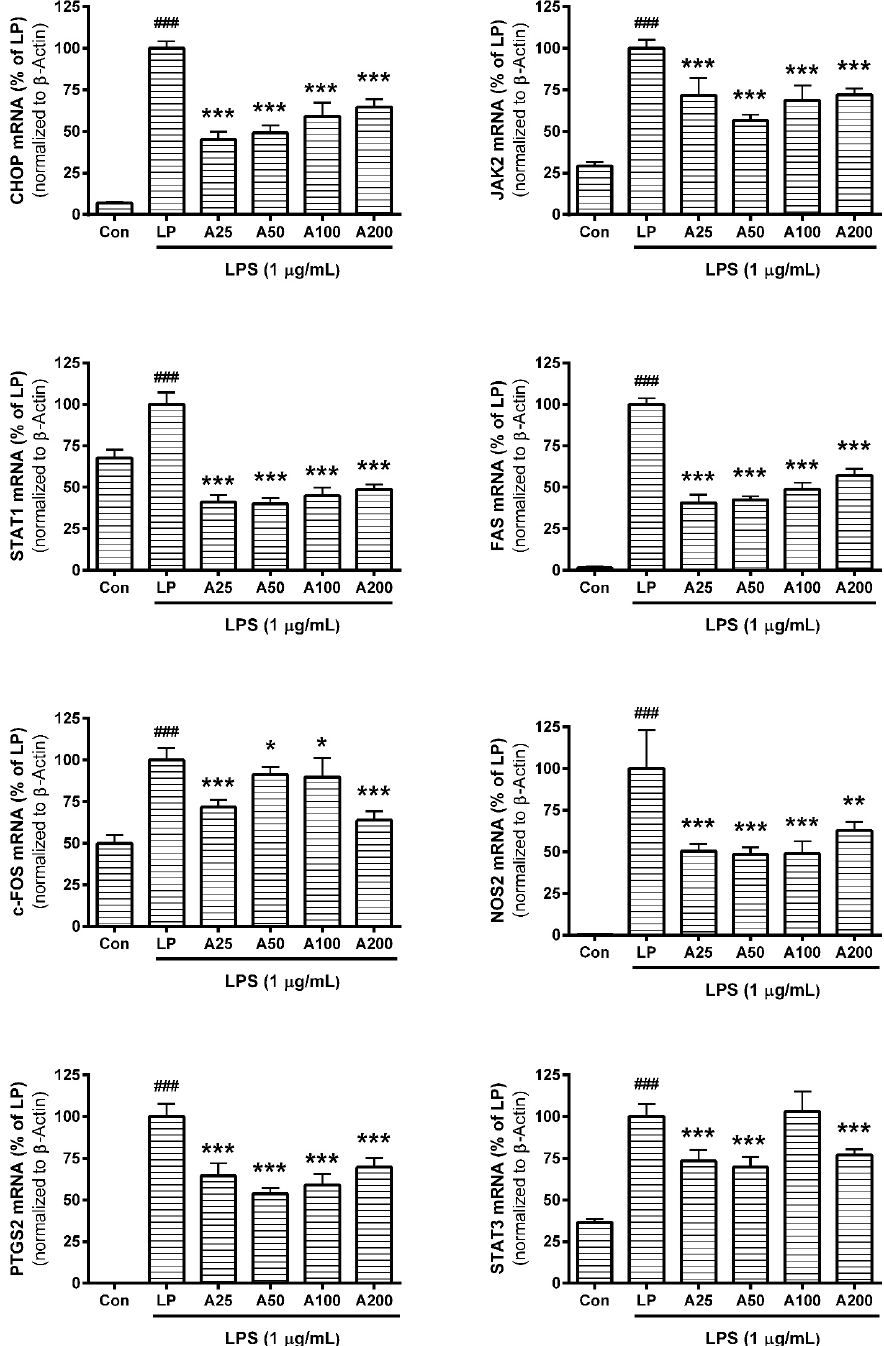
Figure 5. Effects of Angelica sinensis root water extract (ASW) on the mRNA expression of C/EBP homologous protein (CHOP), janus kinase 2 (JAK2), signal transducers and activators of transcription 1 (STAT1), first apoptosis signal receptor (FAS), c-Fos, nitric oxide synthase 2 (NOS2), prostaglandin-endoperoxide synthase 2 (PTGS2), and STAT3 in lipopolysaccharide (LPS)-induced RAW 264.7. Cells were treated for 18 h. Each mRNA was normalized to the housekeeping gene β -Actin mRNA. Con means the group treated with media only. LP means the group treated with 1 µ g/mL of LPS alone. A25, A50, A100, and A200 mean 25, 50, 100, and 200 µ g/mL of ASW respectively. Values are the mean ± standard deviation of at least three independent experiments. Statistical significance was calculated by one-way ANOVA and a Tukey multiple comparison test. ### p < 0.001 vs. Con; * p < 0.05 vs. LP; ** p < 0.01 vs. LP; *** p < 0.001 vs.